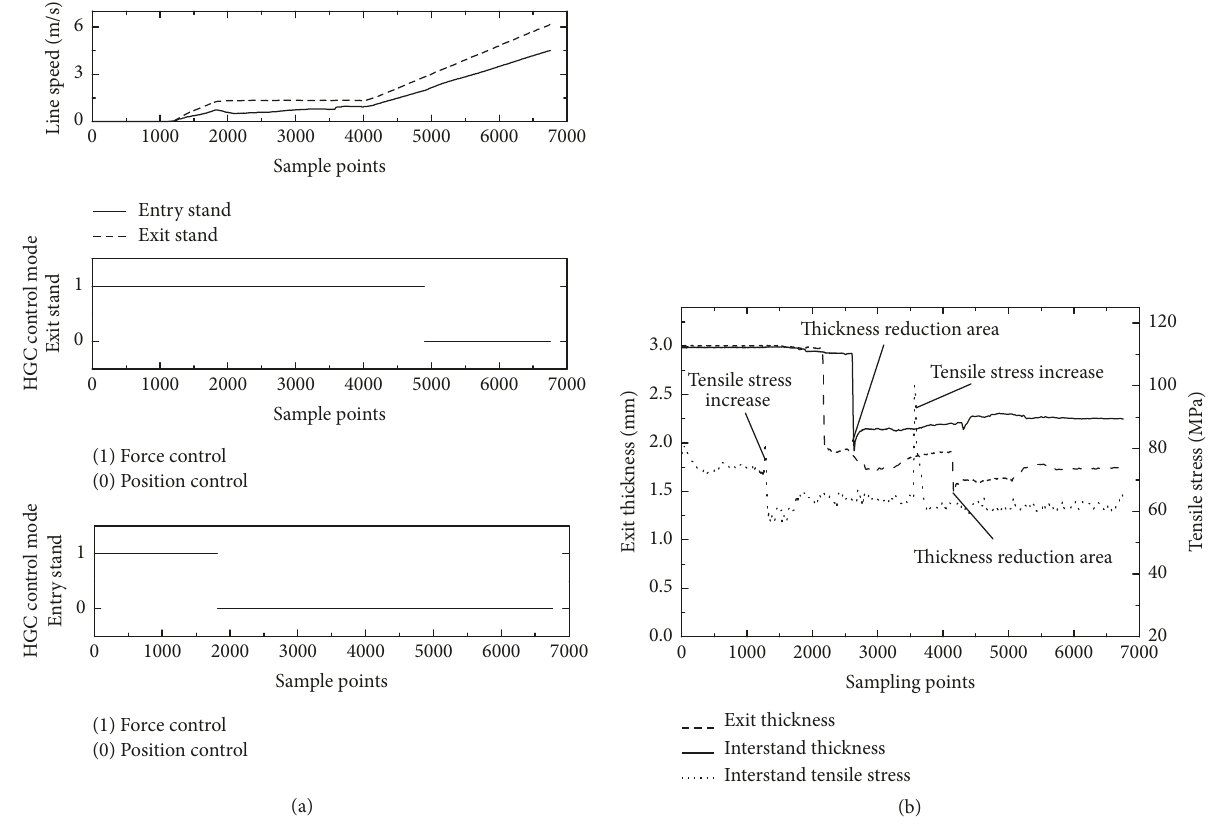
Figure 4: HGC control mode, thickness, and tensile stress variations in the startup process: (a) HGC control mode and line speed variation; (b) tensile stress and thickness